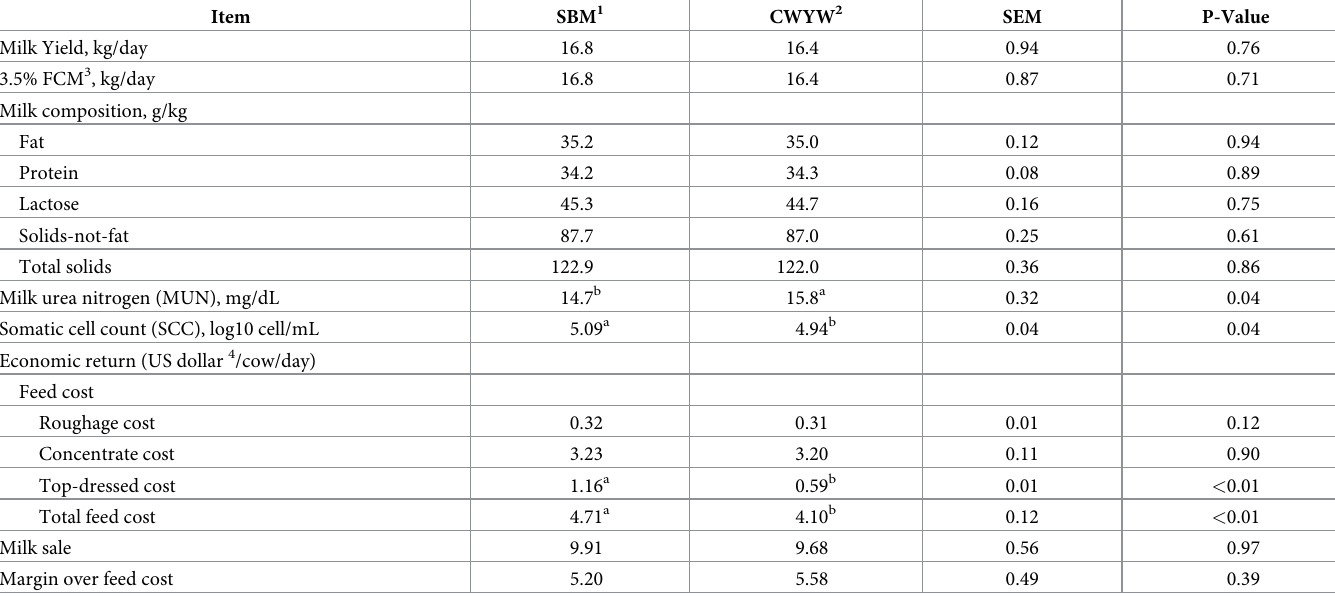
Table 6. Effect of replacing soybean meal with citric waste fermented yeast waste on milk production, chemical composition and economic return.